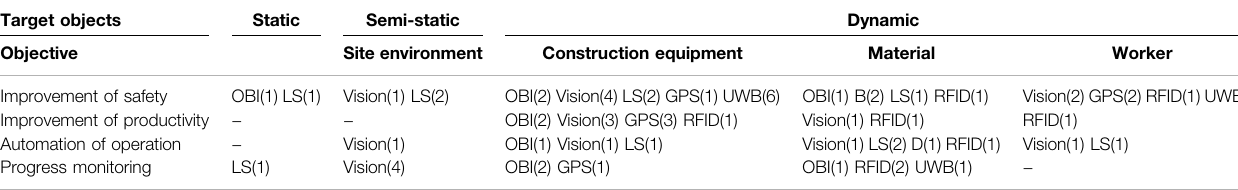
TABLE 1 | A list of objectives and targets of the technology. Target objects Static Objective Construction